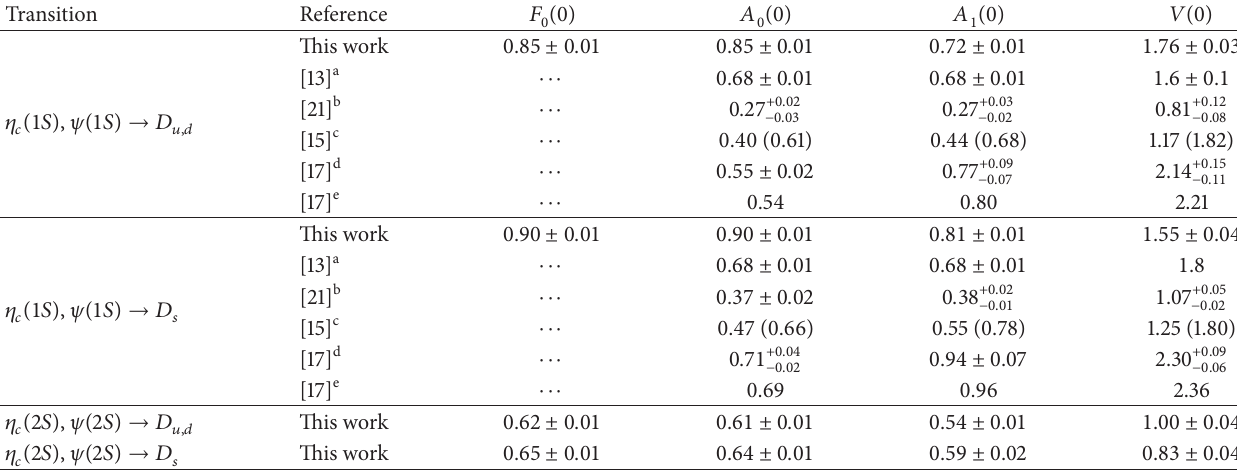
Table 3: The numerical values of transition form factors at 𝑞 2 = 0 , where uncertainties of this work come from the charm quark mass.